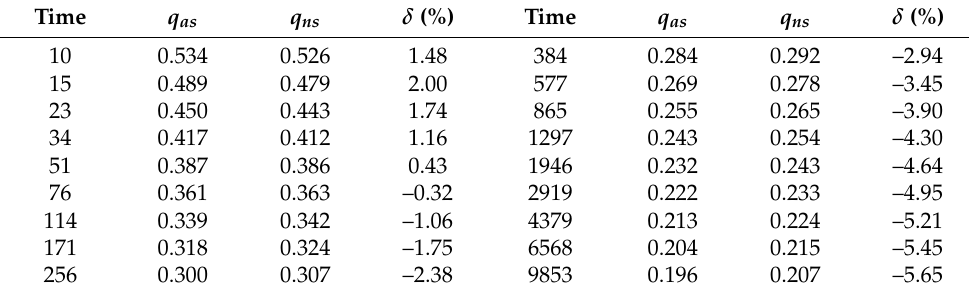
Table 1. Comparison of calculated results under infinite boundary.